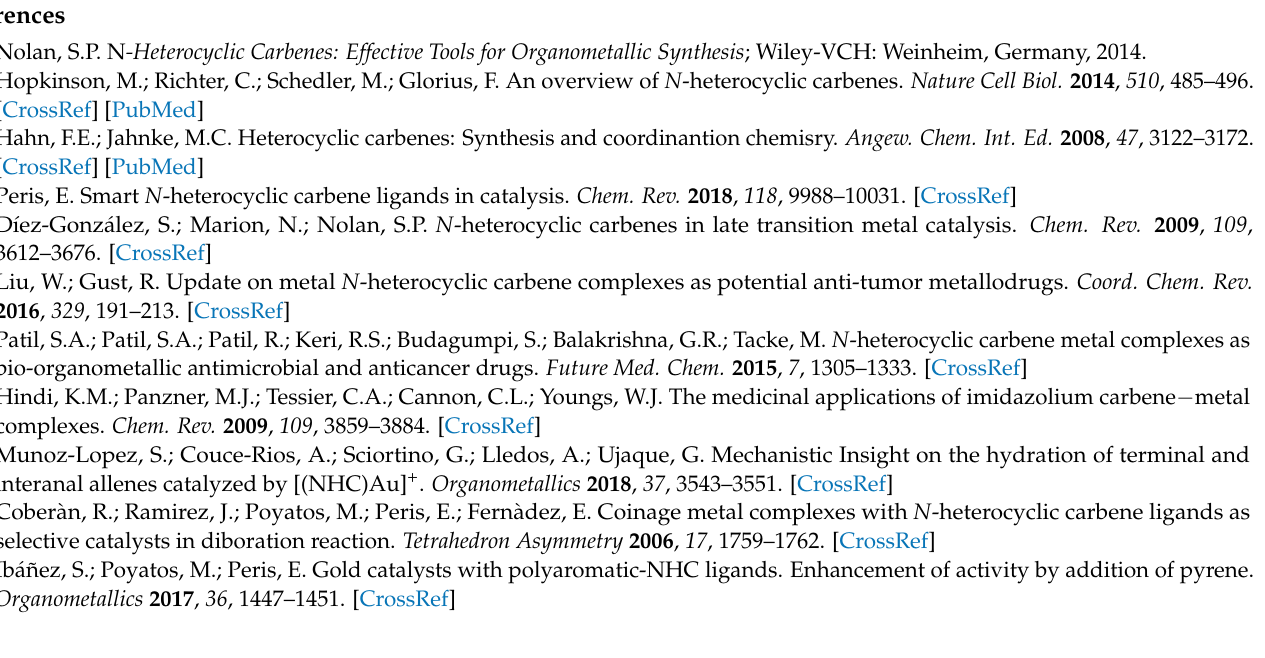
Figure S17: MALDI of 4b